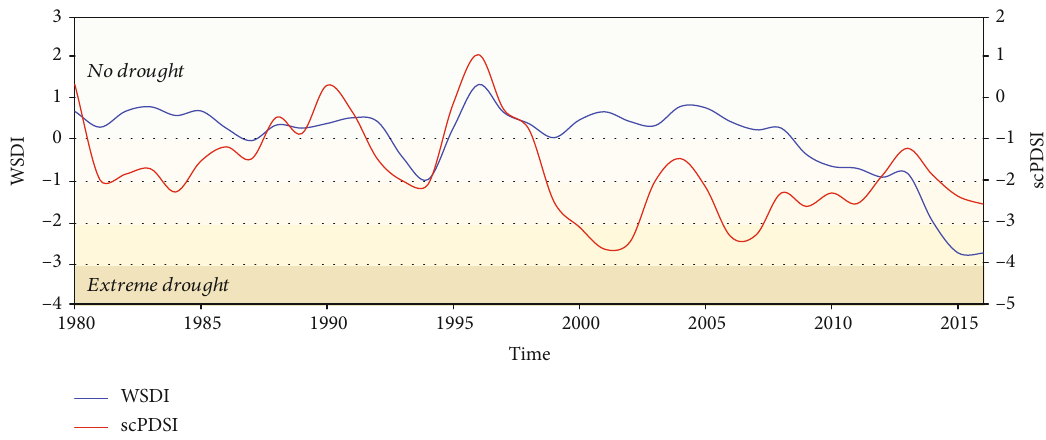
Figure 7: Comparisons of monthly time-series data of the WSDI and